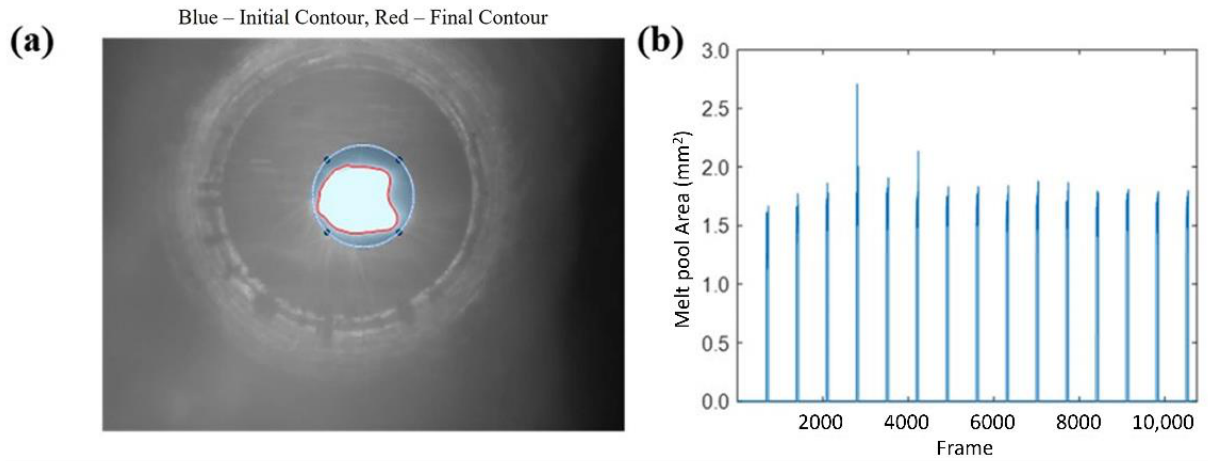
Figure 5. ( a ) Initial mask (blue) and final contour (red) of R-BAC algorithm and ( b ) Melt pool area of specimen 1_C.